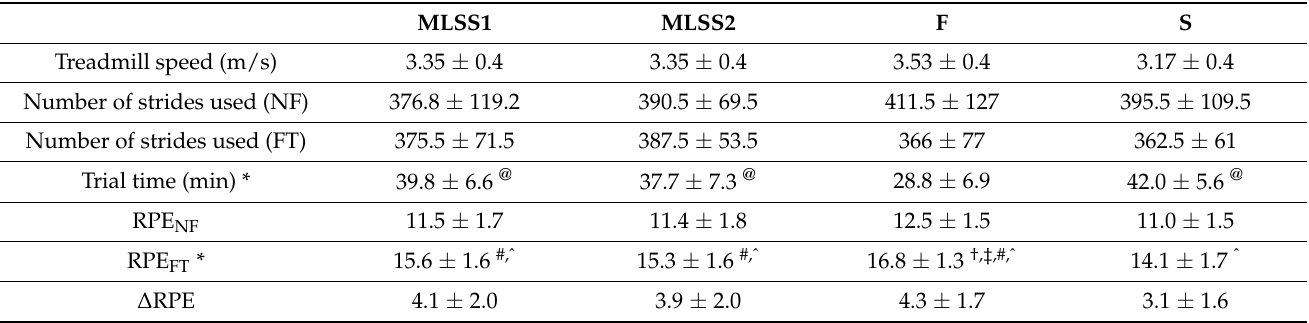
Table 1. Values for trial variables. MLSS1 = first trial at speed at MLSS, MLSS2 = second trial at speed at MLSS, F = trial at 5% faster than speed at MLSS, S = trial at 5% slower than speed at MLSS, NF = non-fatigued state, FT = fatigued state.